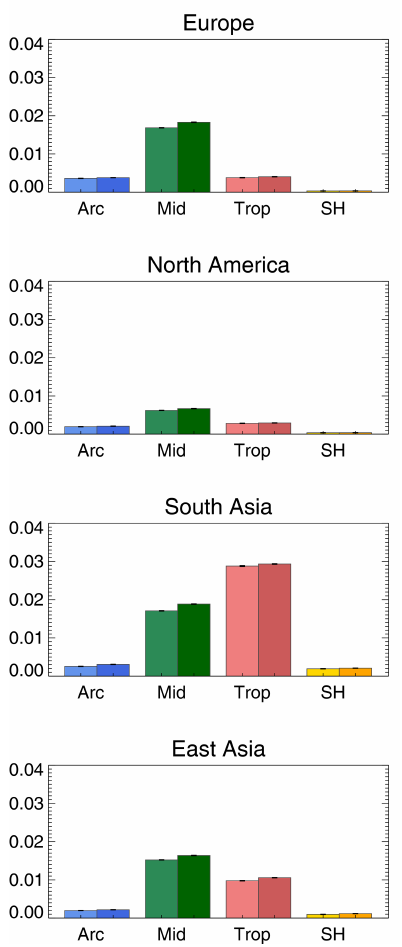
Figure 3. Regional BC burden change per global BC emissions (Tg per Tgyr − 1 ). The emission location (Europe, North America, South Asia, East Asia) is given at the top of each plot. The response re- gion (latitude band) is given on the x axis. The emission rate is doubled in the right-hand side bars (darker colours) compared to the left-hand side bars (lighter colours). The error bars represent the standard error of the